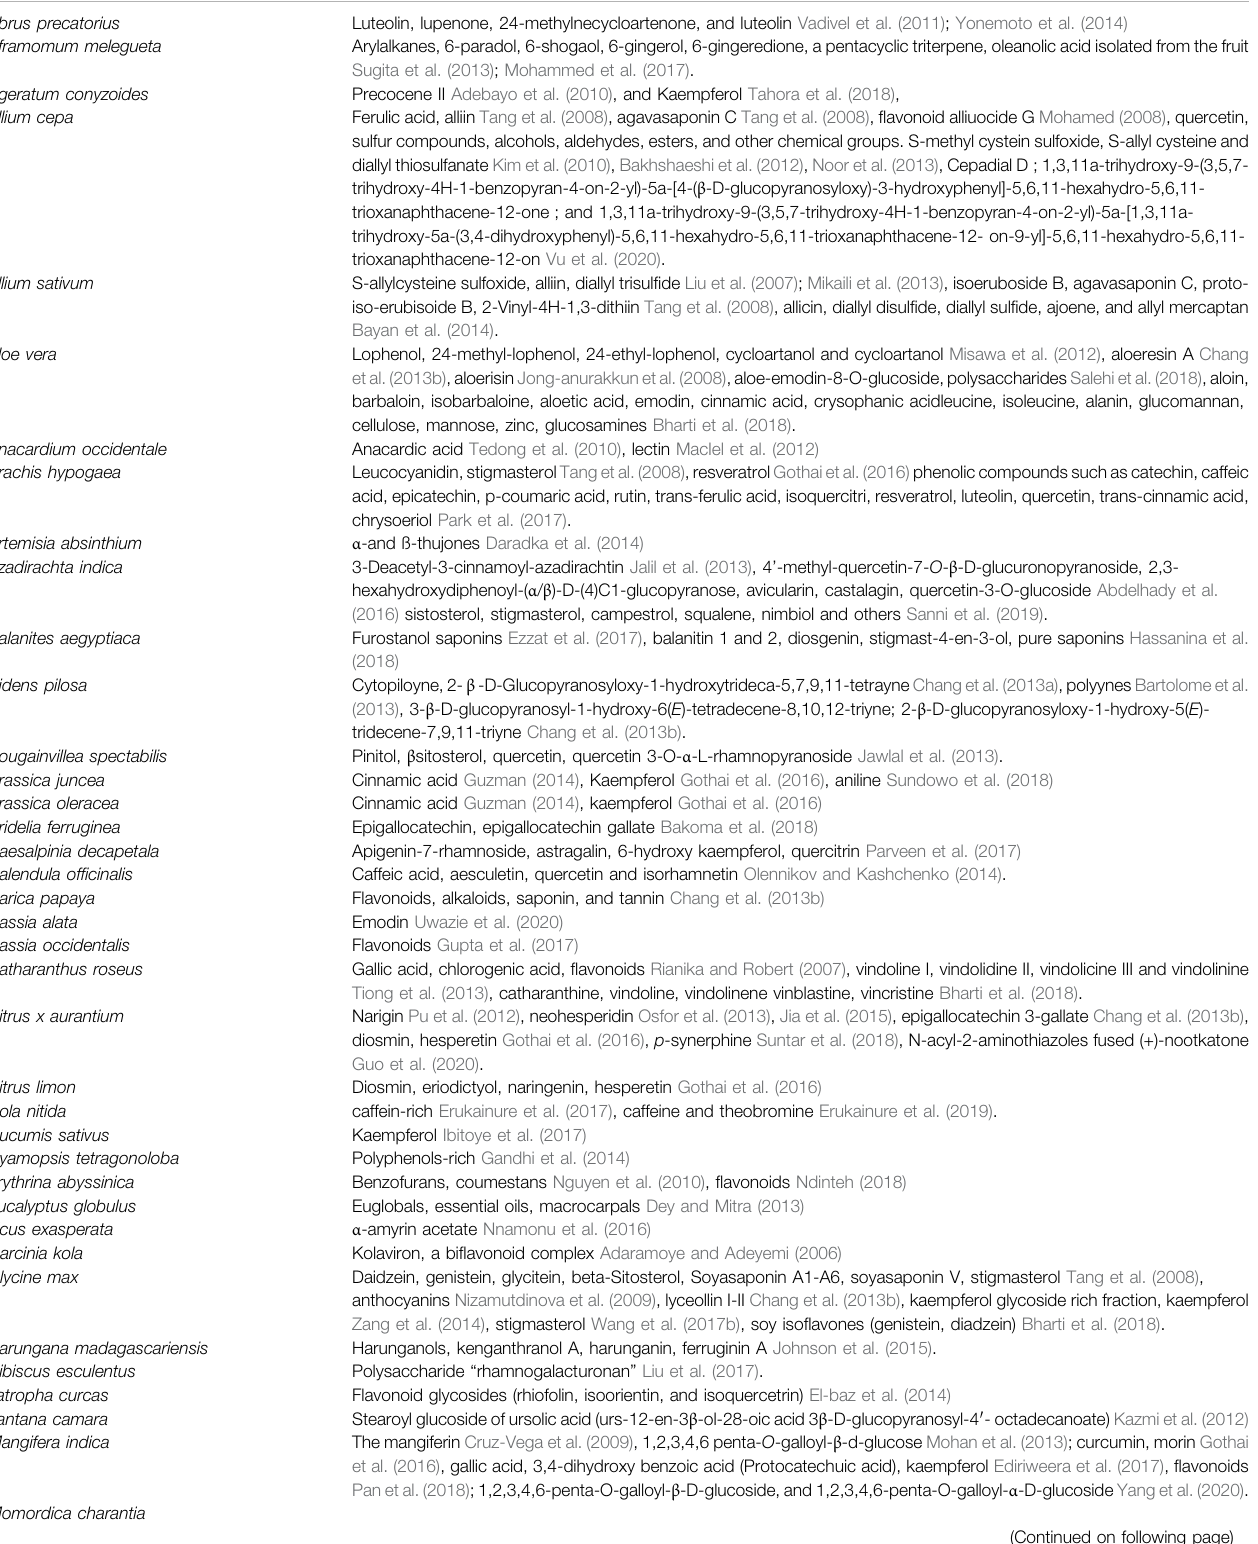
TABLE 6 | Major phytochemicals of each plant with demonstrated antidiabetic